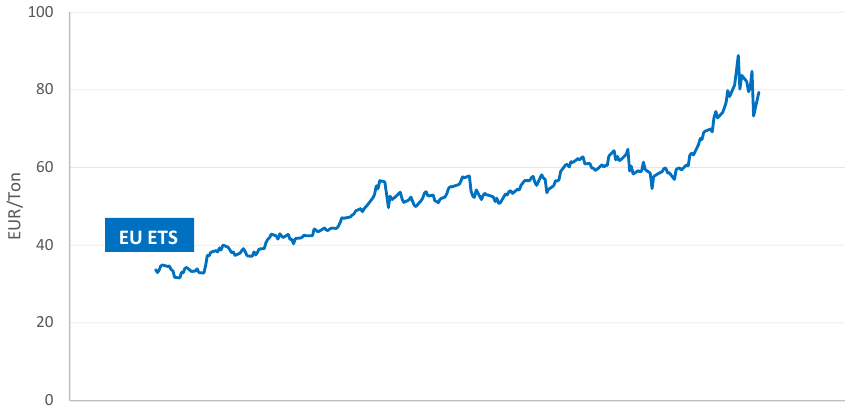
Figure 1. One of the drivers for the energy transition the CO 2eq tax (EUR CO 2eq /ton) volatility in 2021 (https://ember-climate.org/data/carbon-price-viewer/, accessed on 1 January 2022). The marine heterotrophic microalgae Chrypthecodinium cohnii produces significant amounts of intracellular lipids that are rich in docosahexaenoic acid (DHA), a compound that has many applications in the pharmaceutical, nutraceutical, and food industries, due to its well-known benefits on human health. The C. cohnii oil fractionation, to obtain a DHA rich fraction, and another lipidic fraction, rich in saturated/unsaturated fatty acids, that can oil fractions, which may have environmental benefits. Because the biodiesel market